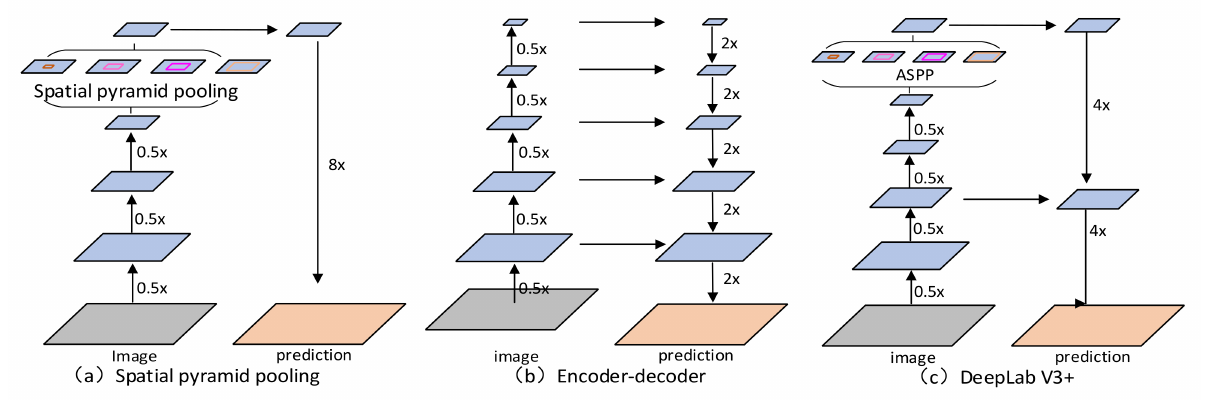
Figure 2. The structure of DeepLab V3+ and relative networks.